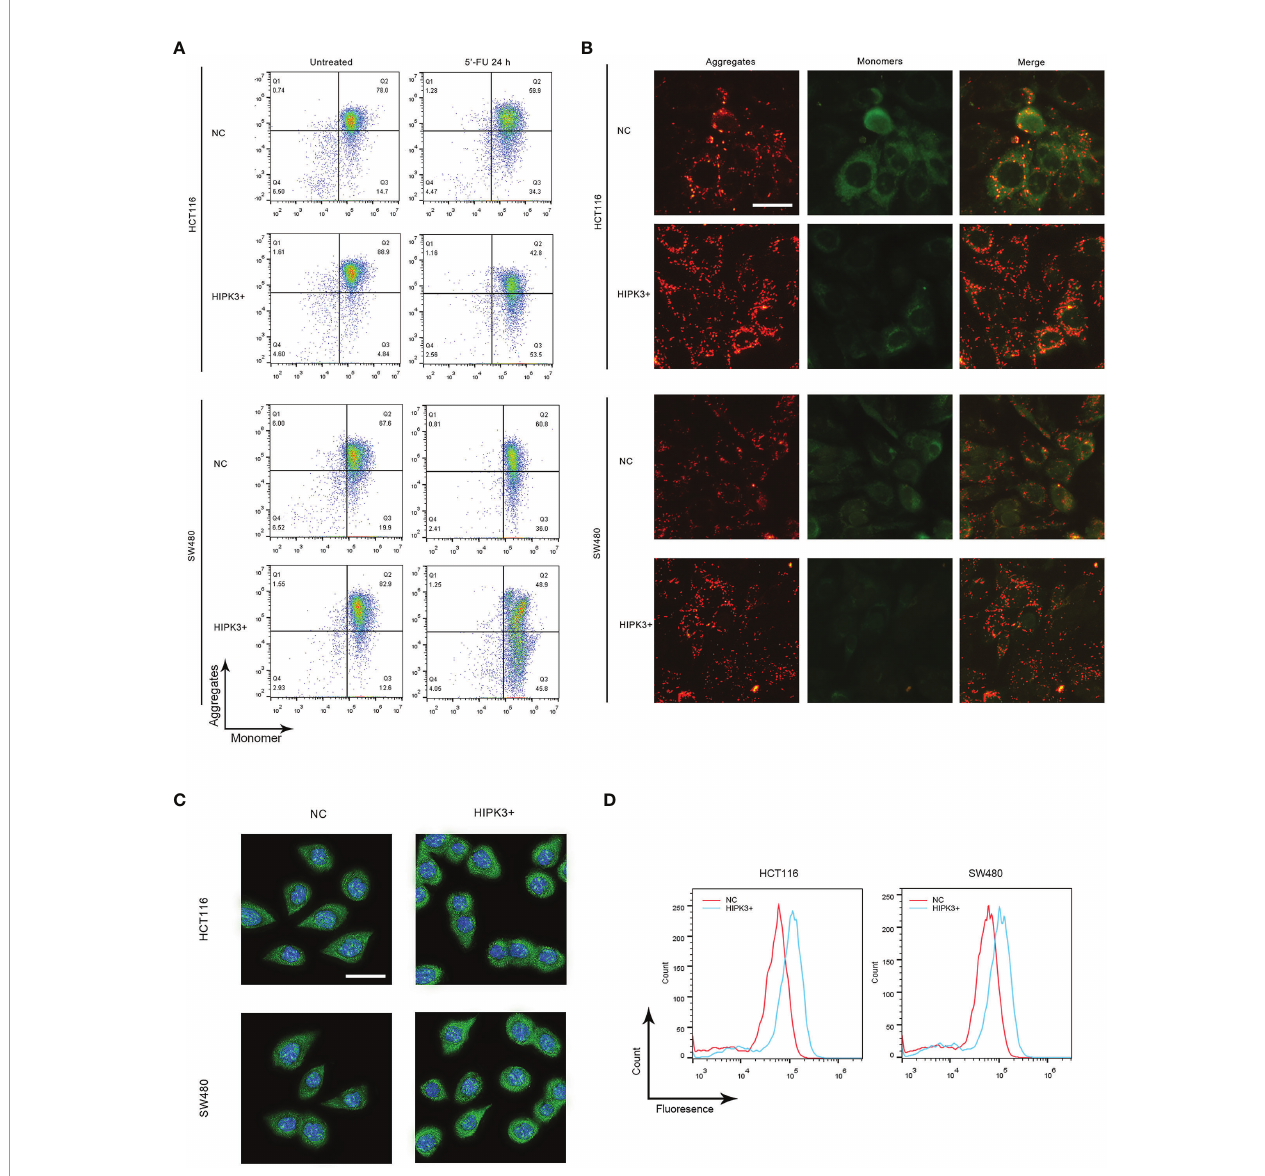
FIGURE 5 | HCT116 and SW480 cells stably over-expressing HIPK3 exhibited alterations in mitochondrial characteristics. (A) Mitochondrial membrane potential monitored by fl ow cytometry using the JC-1 dye. (B) Mitochondrial membrane potential probed by fl uorescence microscopy. (C) Immuno fl uorescence of cytochrome (D) Histogram of cytochrome C generated by fl ow